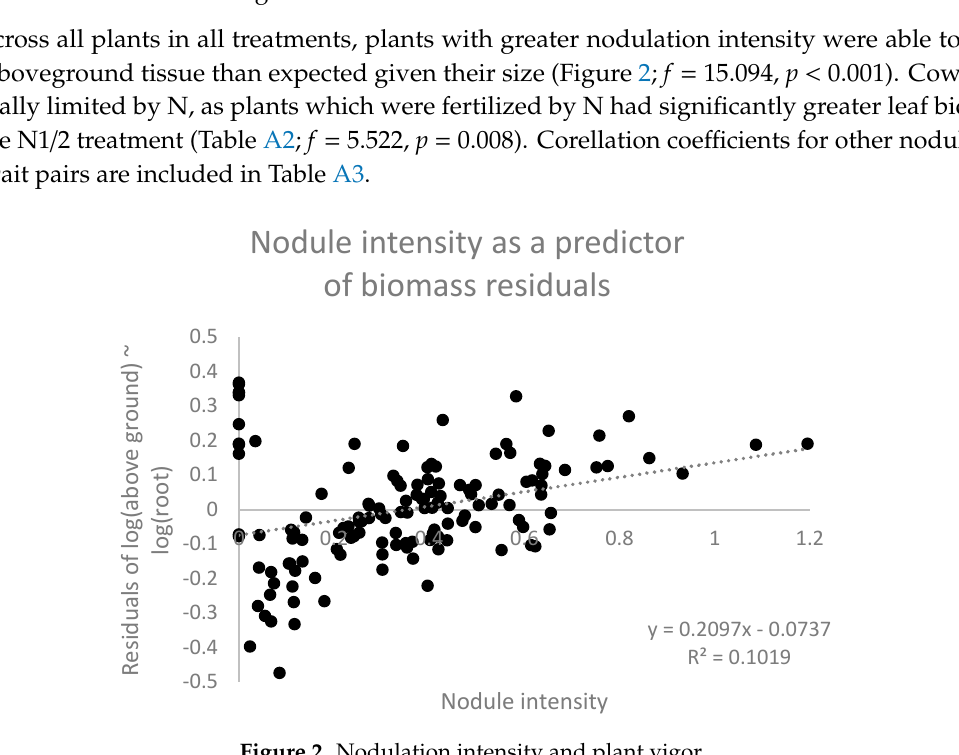
Figure 2. Nodulation intensity and plant vigor. 358